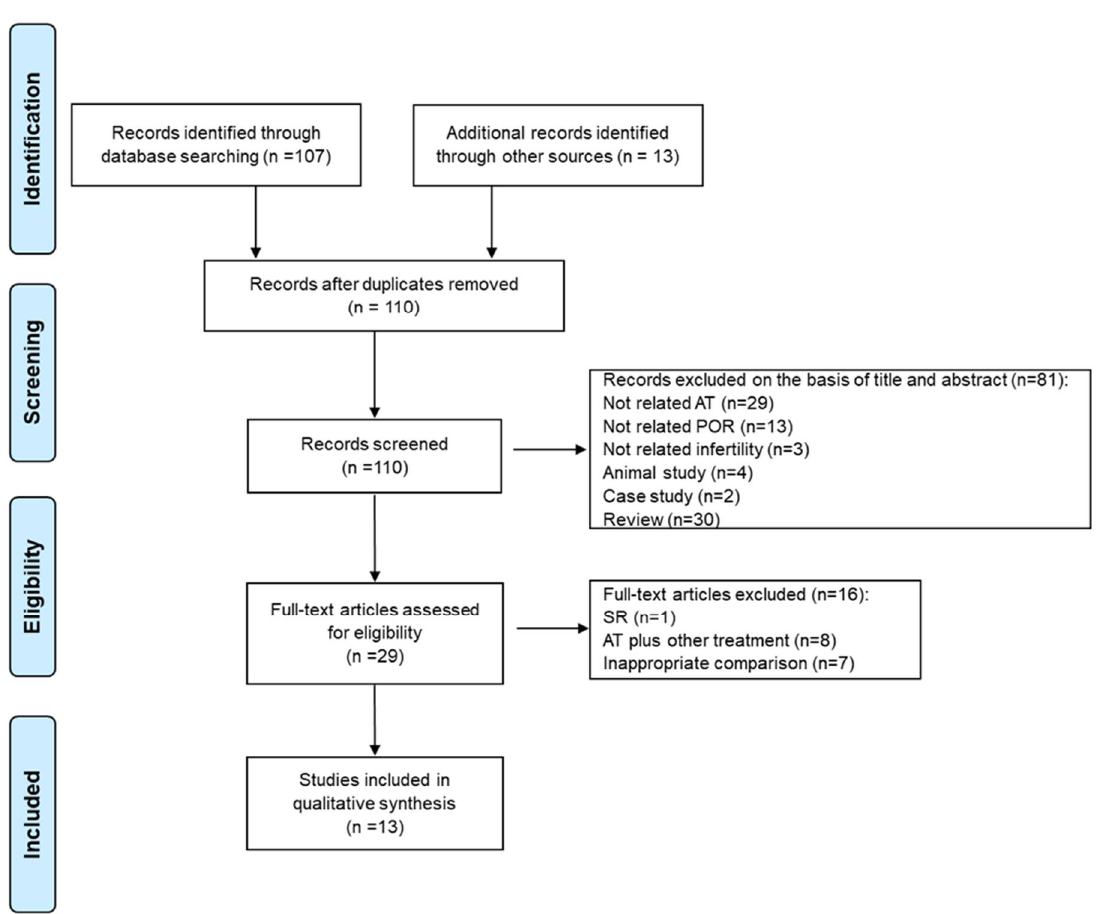
Figure 3. PRISMA flow diagram showing the extraction of candidate acupoints for the treatment of POR. PRISMA, preferred reporting items for systematic reviews and meta-analyses; AT, acupuncture treatment; POR, poor ovarian response; SR, systematic review.